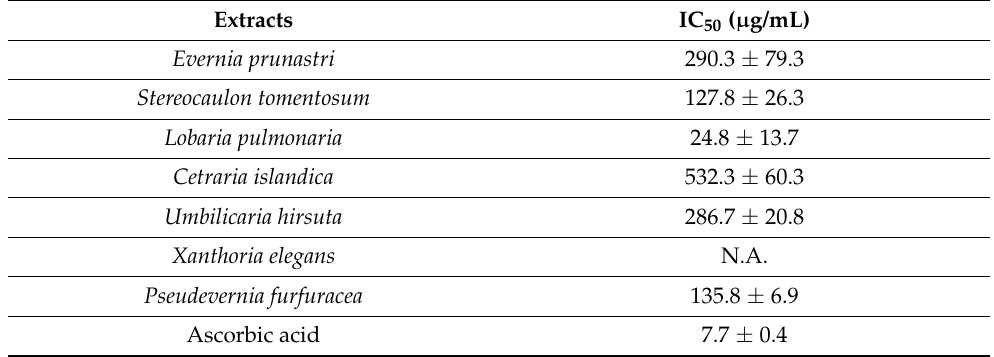
Table 5. IC 50 by DPPH radical scavenging assay of tested